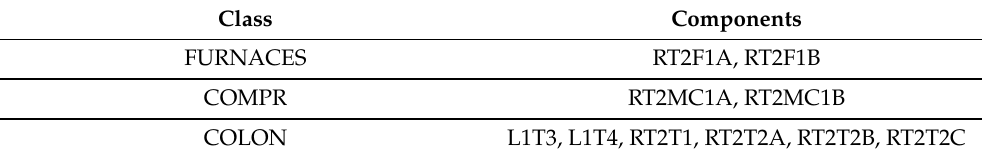
Table 1. Example of three component classes and the elements they include.